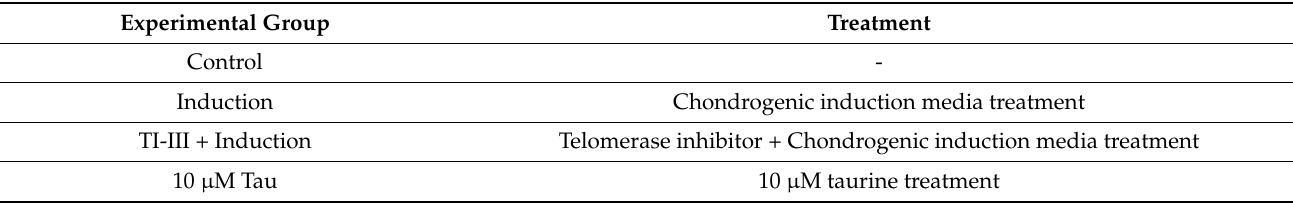
Table 1. Effect of taurine on chondrogenesis—Experimental